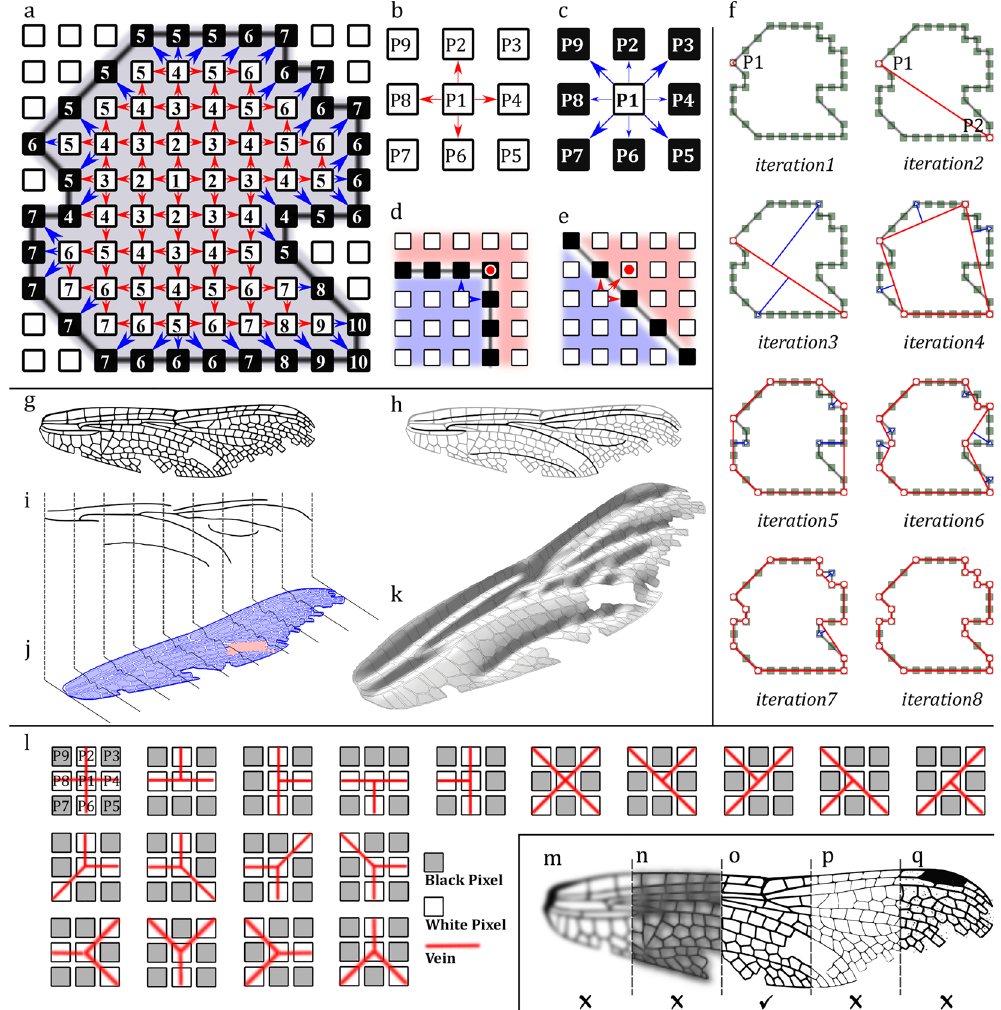
Figure 2. Techniques used in WingGram . ( a ) The fast marching algorithm for detecting the boundary of a domain. ( b ) cardinal directions to find new white pixels in the fast marching algorithm. ( c ) All directions to find new black pixels in the fast marching algorithm. ( d ) The fast marching algorithm may miss the point if only the cardinal directions check for finding new black pixels. ( e ) Percolating to neighbour domains may occur if the fast marching algorithm checks all the directions for finding new white pixels. ( f ) Ramer-Douglas-Peucker line simplification algorithm. ( g – k ) Assignment of wing corrugations. ( g ) The wing image. ( h ) Highlighted corrugated spots. ( i ) The secondary image (divided into several sections). ( j ) Assignment of sections to the main image. ( k ) The developed corrugated model. ( l ) Defined conditions for the identification of vein junctions. ( m – q ) Suitable and non-suitable images. ( m ) fade image. ( n ) Dark image. ( o ) Appropriate image. ( p ) Thin and unclear venations. ( q ) Salt and pepper